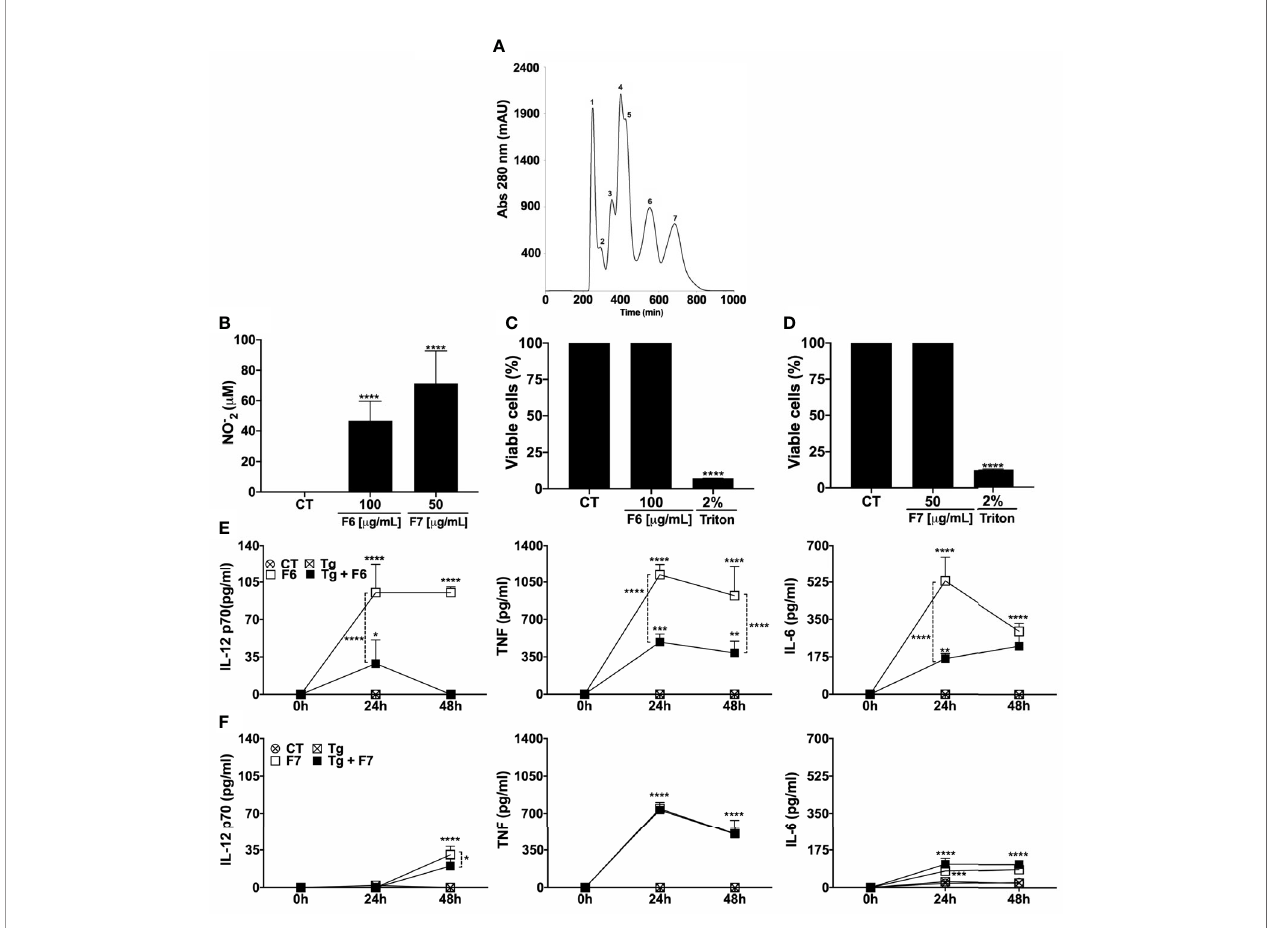
FIGURE 2 | F6 fraction from TsV triggers the production of pro-in fl ammatory mediators and induces macrophage anti-protozoal activity. TsV was separated by gel fi ltration chromatography in which the components were eluted at a fl ow rate of 0.5 mL/min and protein detection was performed at 280 nm. The fractions obtained were listed from 1 – 7 (A) Peritoneal macrophages were cultured and stimulated with F6 or F7 fractions (100 or 50 µg/mL, respectively), and at 48 h post-stimulation the culture supernatants were collected for nitric oxide measurement (B) . Viability assay (MTT) was performed on the adhering cells at 48 h after F6 (100 µg/mL) (C) or F7 (50 µg/mL) stimulation (D) . The cells were infected (1:1 parasite: cell ration) and/or stimulated with F6 (100 µg/mL) or (F7 50 µg/mL) and the culture supernatants were collected at 24 and 48 h post-stimulus; (E) F6 and (F) F7, for cytokine measurements (IL-12p70, TNF, and IL-6). Each point represents means ± SEM of one of the two independent experiments, * p ≤ 0.05; ** p < 0.01; *** p < 0.001; **** p <